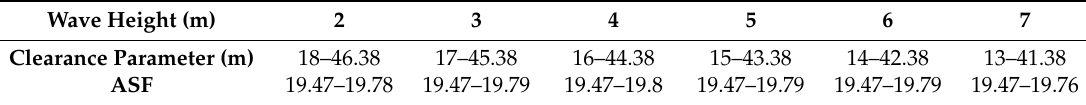
Table 1. The corresponding data change table of Figure